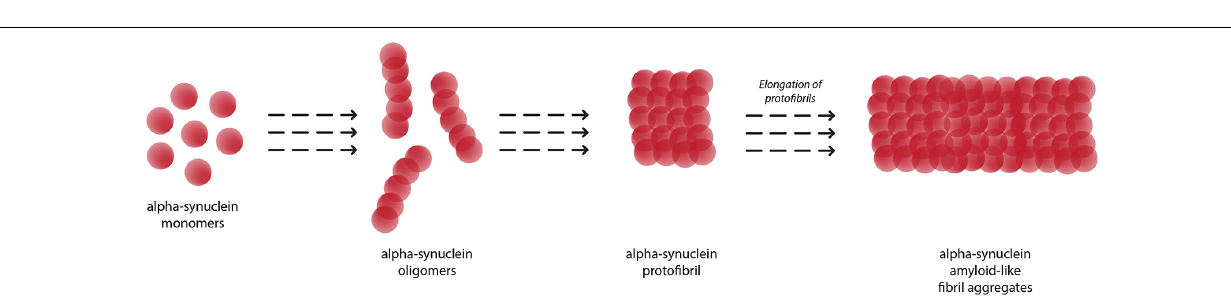
FIGURE 2 | Aggregation of alpha-synuclein monomers into eventual insoluble fibrils, with oligomer and protofibril formation as